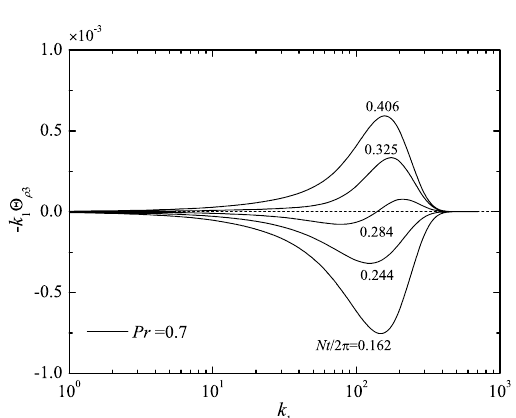
Fig. 4 Time variations of the cospectra of the vertical turbulent scalar flux in thermally stratified air flow. PE 0 / KE 0 = 0 . 3. The values of k 0 k and k 0 p are the same as those in Fig.3